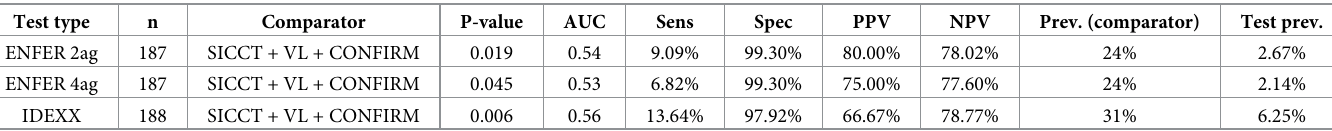
Table 3. The relative performance of serological tests against a combination of statutory ante-mortem and post-mortem diagnostic techniques. Test type